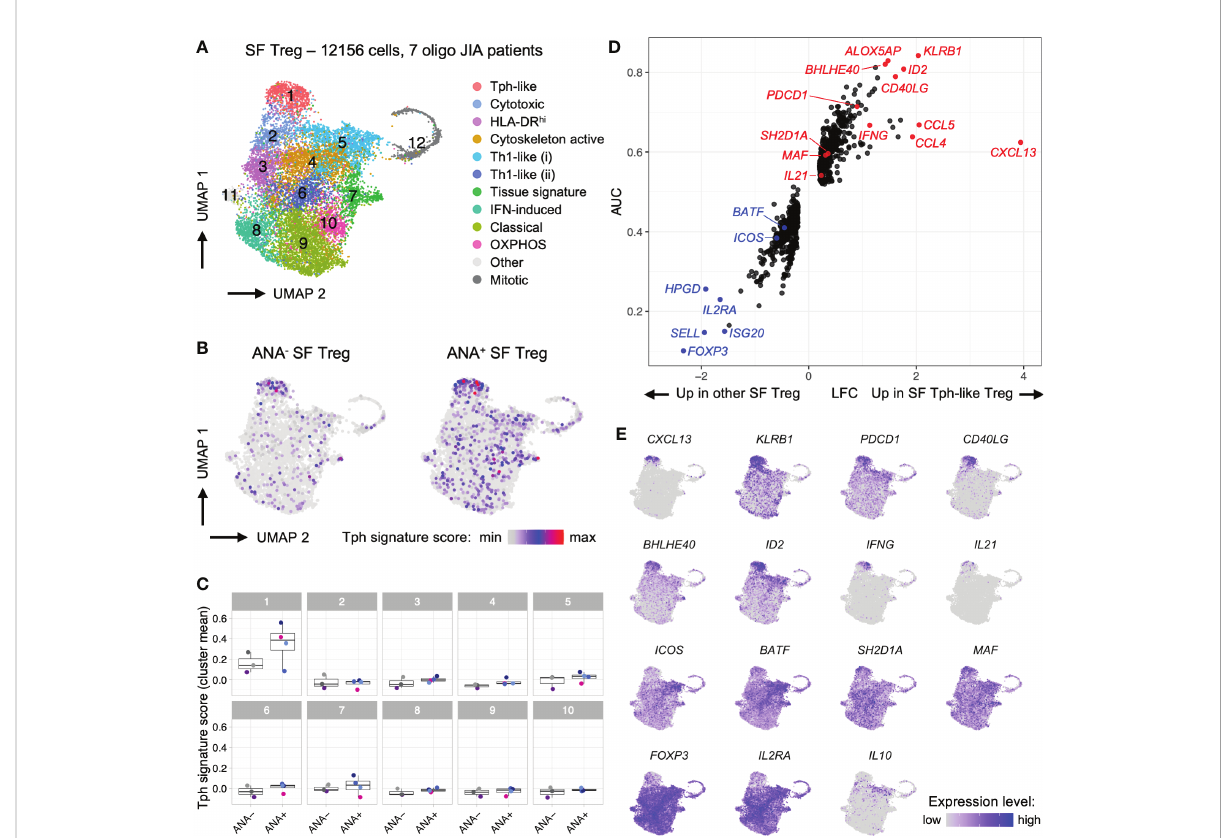
FIGURE 6 T regulatory cells in oligo JIA synovial fl uid adopt a distinctive transcriptomic signature characterized by robust expression of CXCL13. Combined data from two previously published datasets of oligo JIA SF Treg (CD4 + CD127 lo CD25 + ) cells studied with 10X Genomics (34, 45). (A) UMAP of SF Tregs from 7 oligo JIA patients, color-coded by cluster. (B) UMAP of SF Tregs split between ANA - (4550 cells) and ANA + (7606 cells) groups, color-coded with their Tph signature score. (C) Mean Tph signature score, averaged per patient and cluster. Multiple T-test comparisons of ANA - versus ANA + groups revealed no signi fi cant difference after FDR correction. (D) LFC versus AUC plot of differential expression analysis of SF Tph-like Tregs (Cluster 1) versus other SF Tregs (Clusters 2-11) run with Seurat v4 using the receiving operating characteristic (ROC) approach. (E) UMAP of SF Tregs showing expression levels of selected Tph-like Treg genes in the top 95% percentile of the gene expression level distribution for each gene. Oligo JIA; oligoarticular juvenile idiopathic arthritis; SF, synovial fl uid; Treg, T regulatory cell; Tph, T peripheral helper cell; ANA, antinuclear antibody; OXPHOS, oxidative phosphorylation; UMAP, uniform manifold approximation and projection; AUC, area under the curve; LFC, log2 fold change; FDR, false discovery